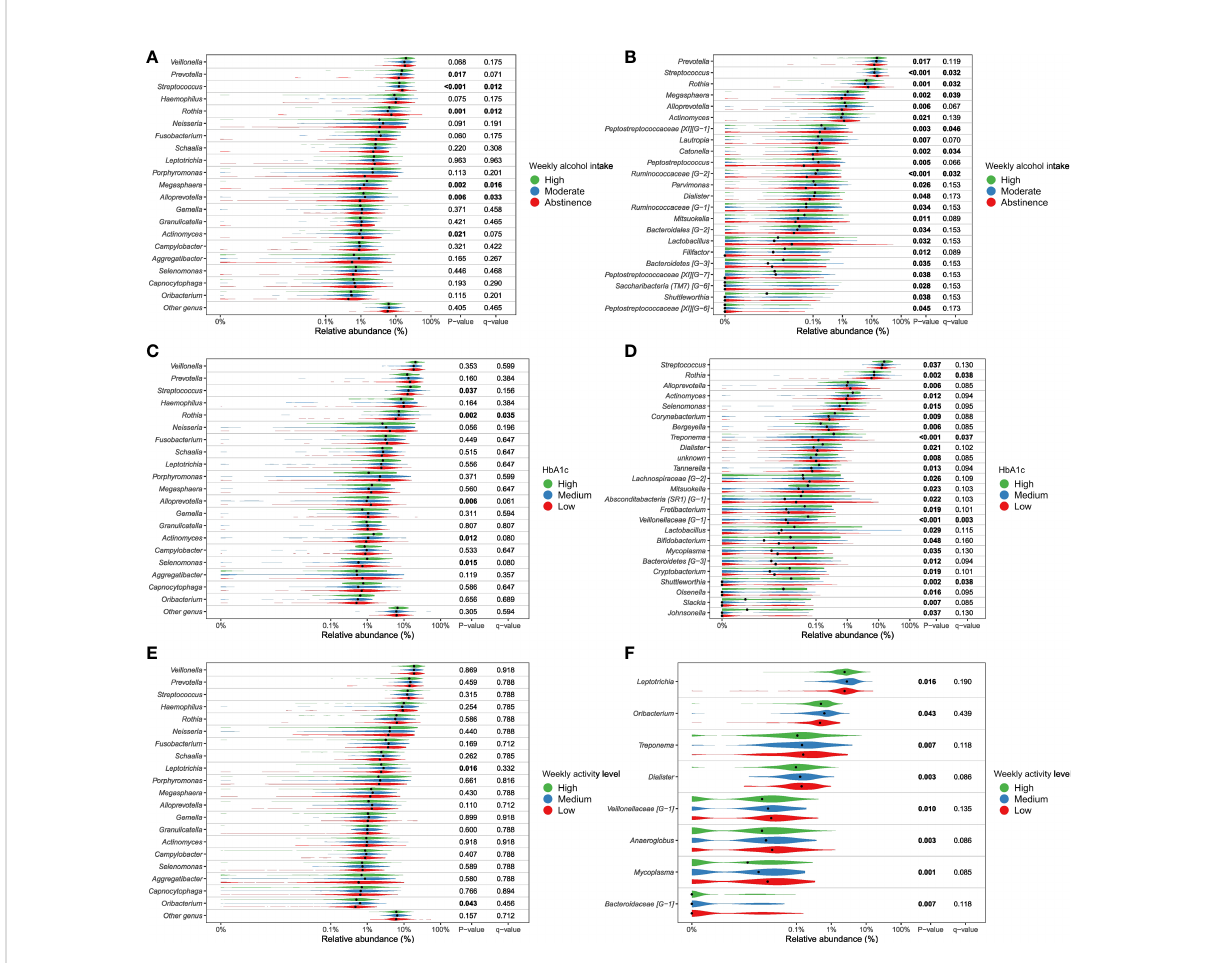
FIGURE 4.2 Genera signi fi cantly associated with alcohol intake, Hb1Ac and physical activity. Relative abundance of most abundant genera (panels A , C , E ) and differential abundant genera (panels B , D , F ). Comparison of groups were performed with non-parametric tests (Kruskal-Wallis). Unadjusted p-values as well as Benjamini-Hochberg corrected q-values are included in the plot. (A, B) weekly alcohol intake, (C, D) Hb1Ac, (E, F) weekly activity level. All tests are included in Supplementary File 2 as well as a parametric approach (DESeq as implemented in DAtest) in Supplementary File